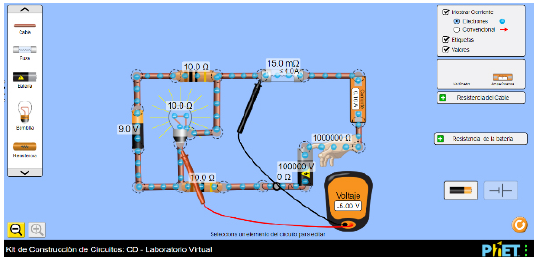
Fig. 2. Circuit construction kit (AC+DC), virtual lab